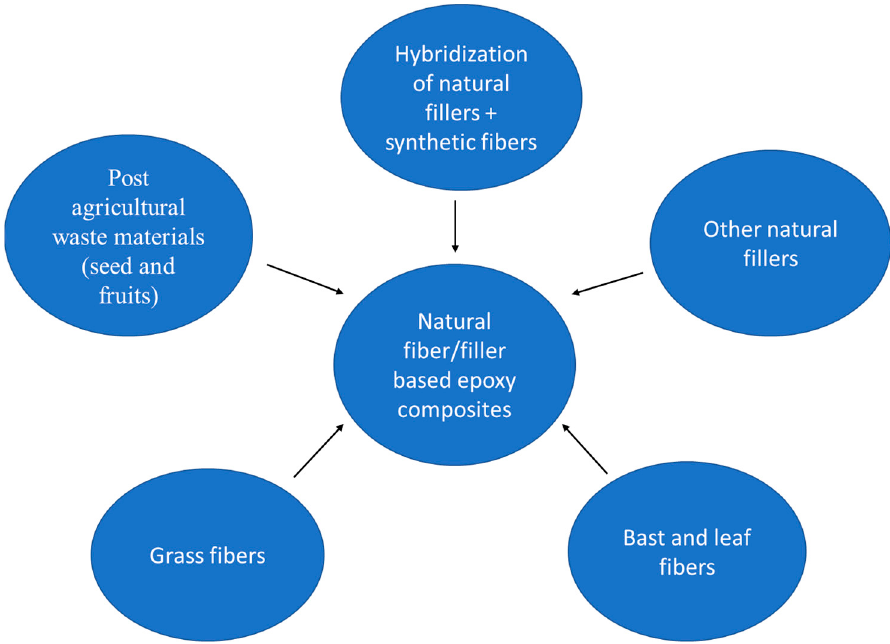
Figure 2. A schematic of various natural fibers used for the development of natural fiber/filler-reinforced epoxy composite.